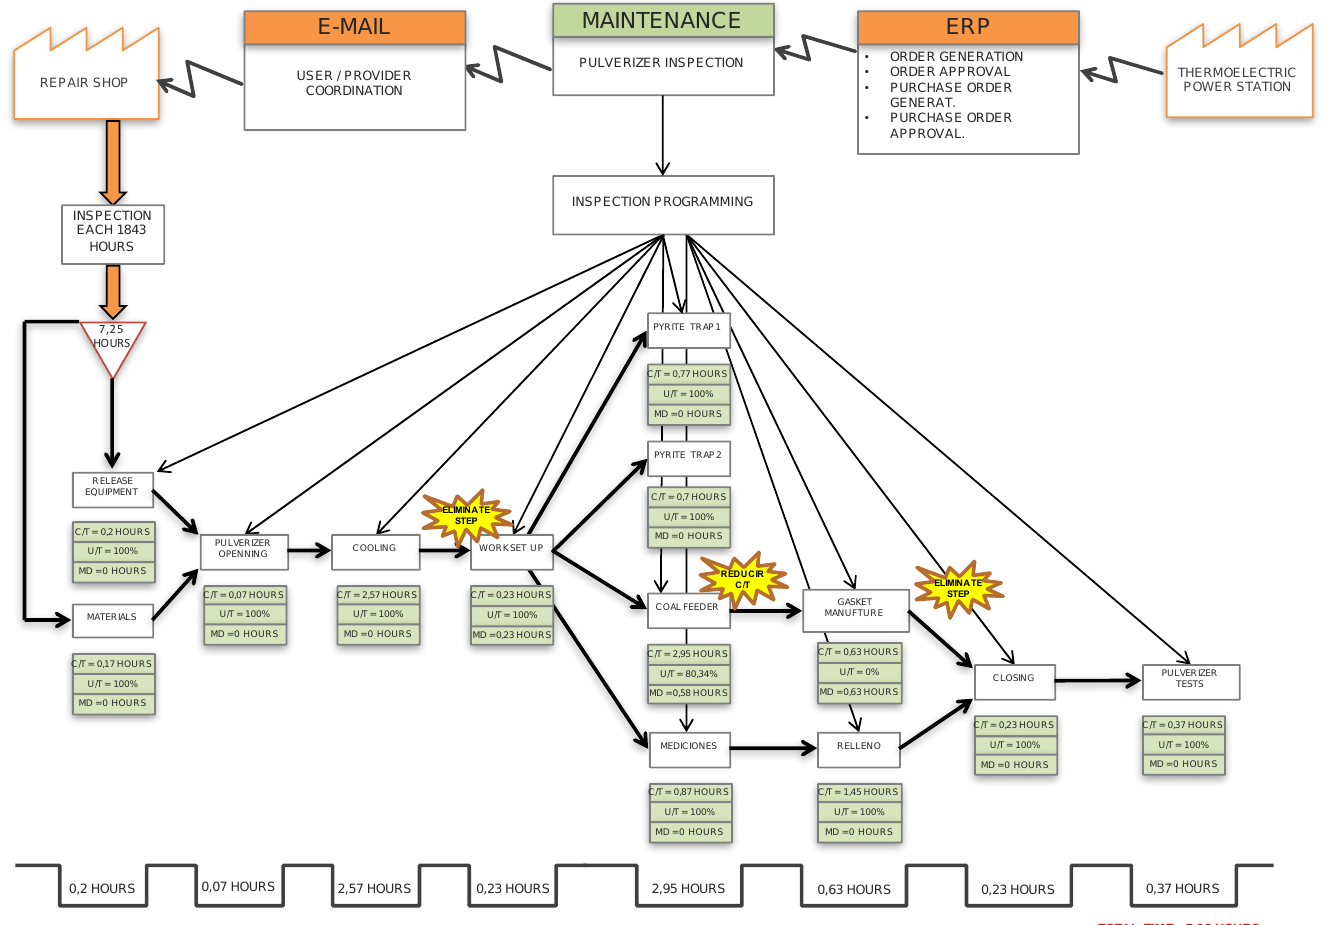
Figure 9. The value stream map of the current state.